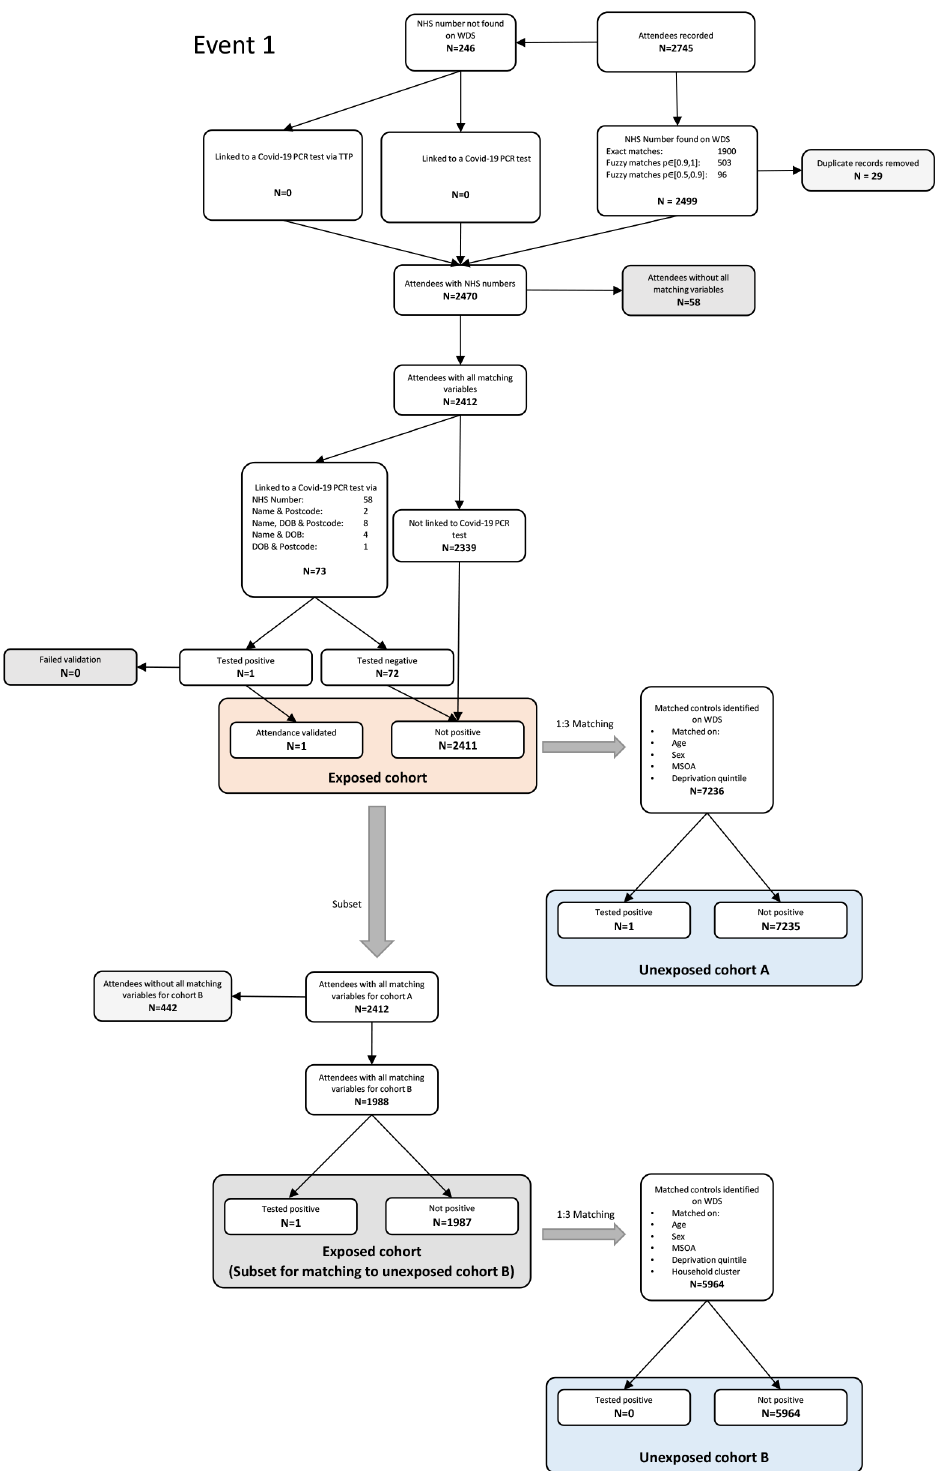
Figure S1: Flow chart of cohort selection for event